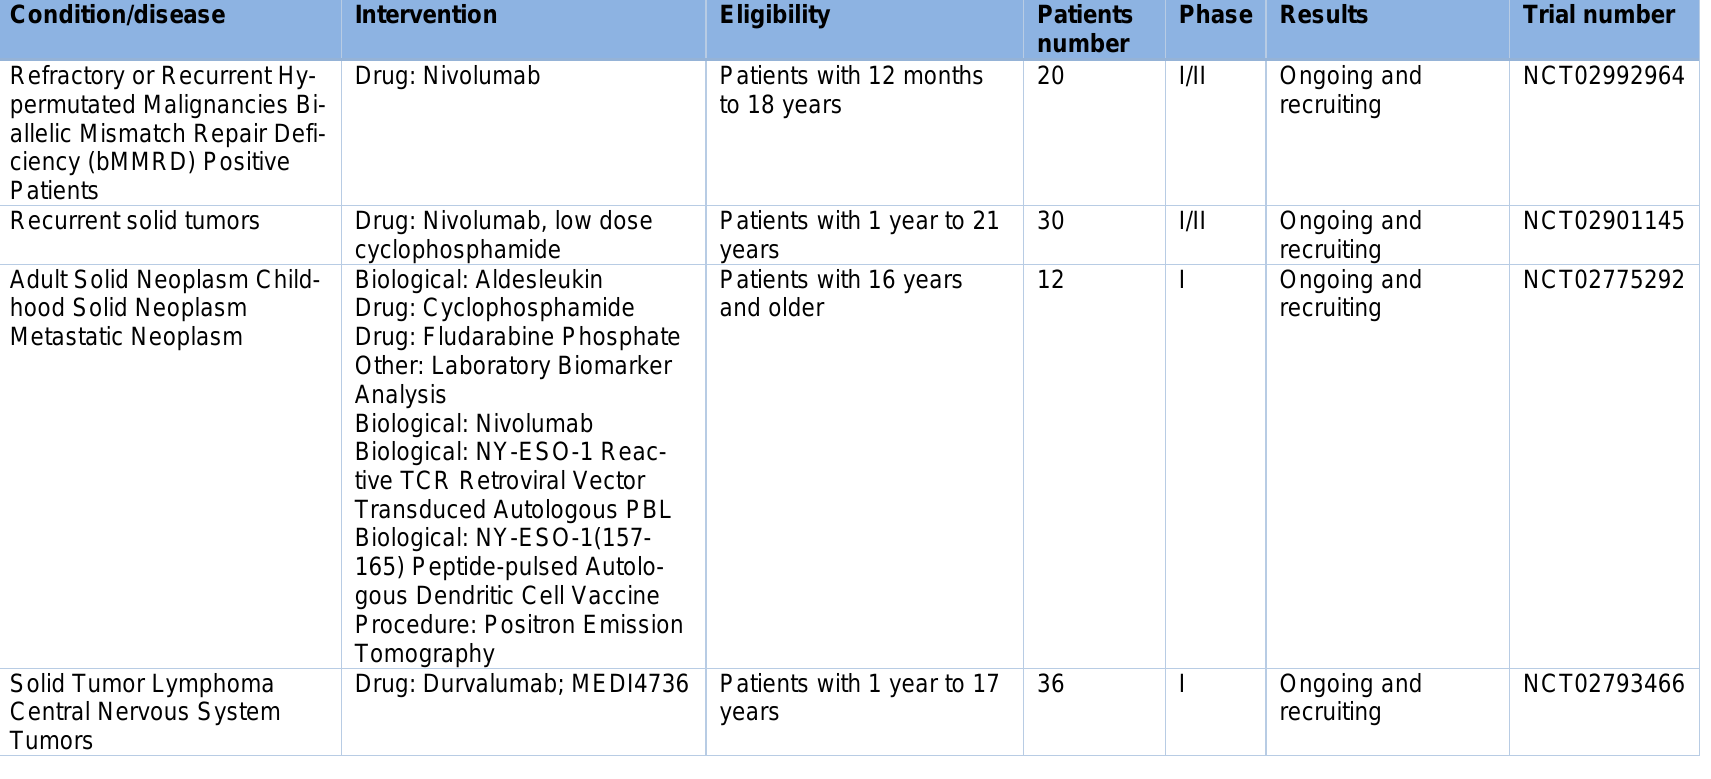
Table 1 (cont.): Clinical trials for osteosarcoma by checkpoint inhibitor